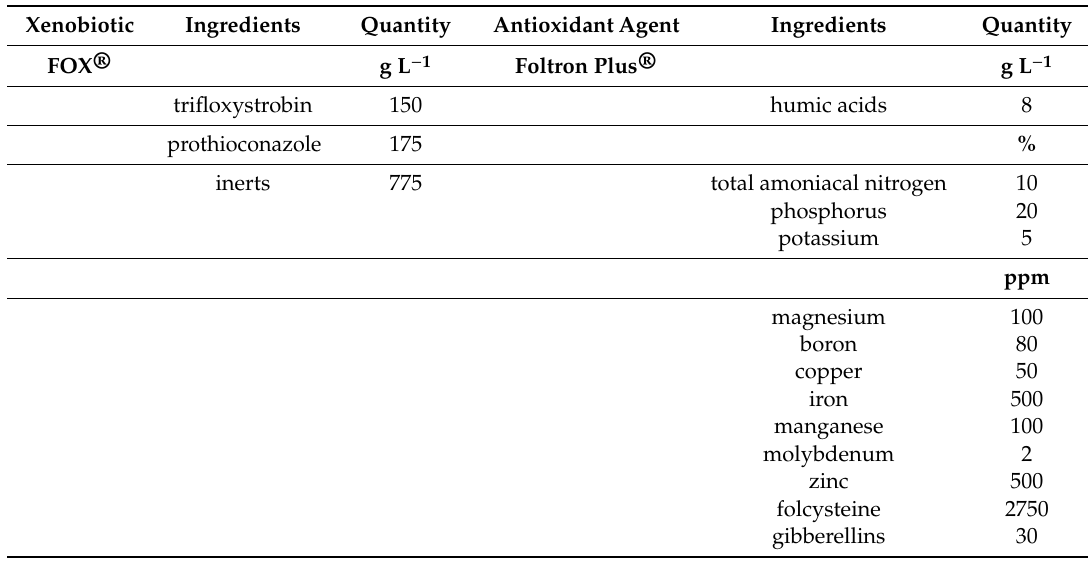
Table 1. Xenobiotic and antioxidant agent